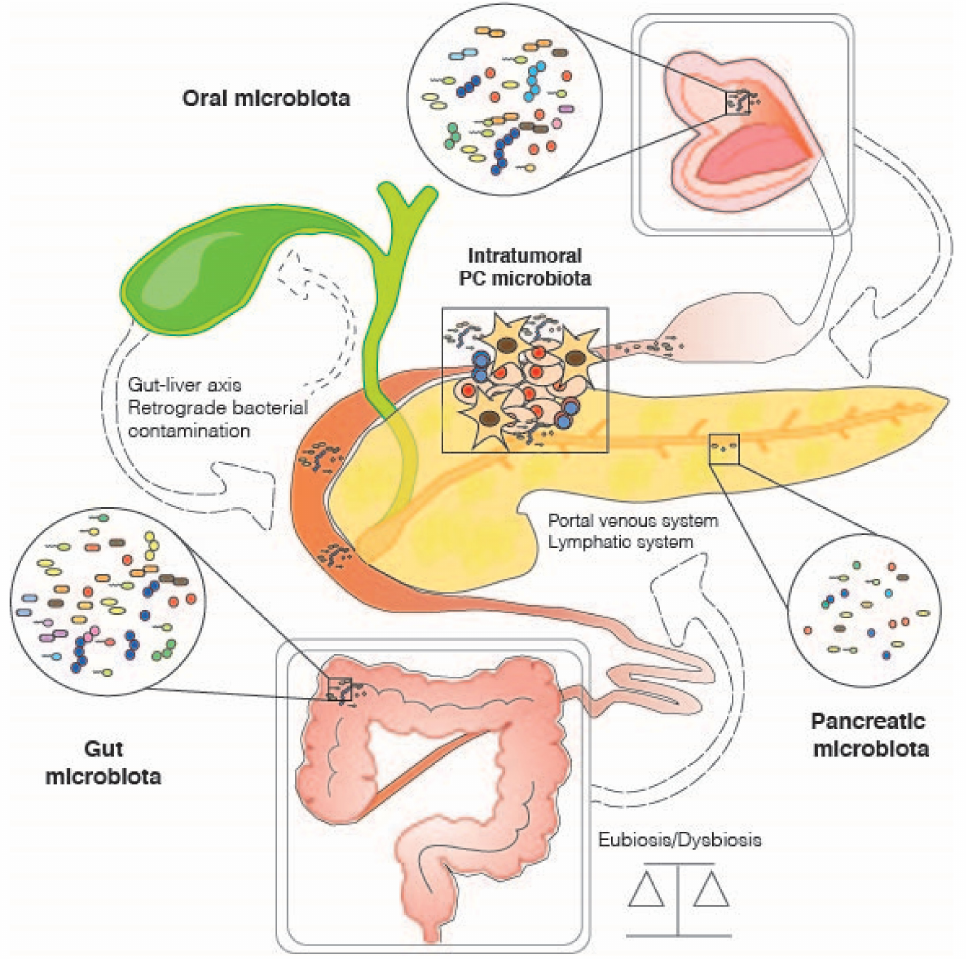
Figure 1. Potential bacterial interchange routes between gut, oral and intra-tumoral PC-associated